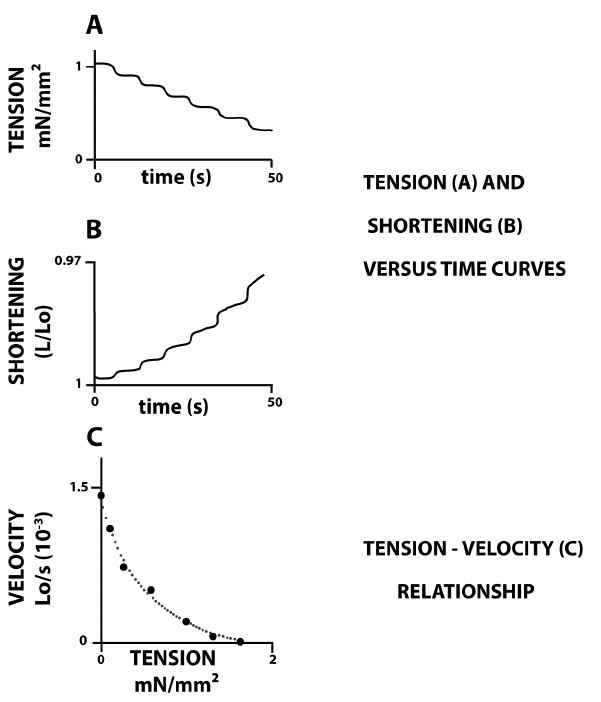
Figure 2. Hyperbolic Tension-Velocity (T-V) relationship under KCl exposure. In panel A, the isometric tension level T was progressively decremented by successive steps of 0.1 mN from maximum tension to zero-tension (Panel A: PSV tension versus time curve). In panel B, (PSV shortening length versus time curve), at each step, PSV shortened longitudinally at a given constant isotonic tension level (T) and constant velocity (V). The slope of the isotonic shortening length, i.e., the PSV shortening velocity, progressively increased when the isotonic tension (T) level decreased, until a maximum value Vo reached at zero-tension. In this example, the hyperbolic T-V relationship was derived from the velocity (V) of 7 isotonic afterloaded contractions, plotted against the isotonic tension level, according to the classic A.V. Hill equation (T + a) (V + b) = (To + a) b, where – a and – b are the asymptotes of the hyperbola [15]. The hyperbolic T-V relationship obtained under electrical tetanus was strictly similar (not represented).